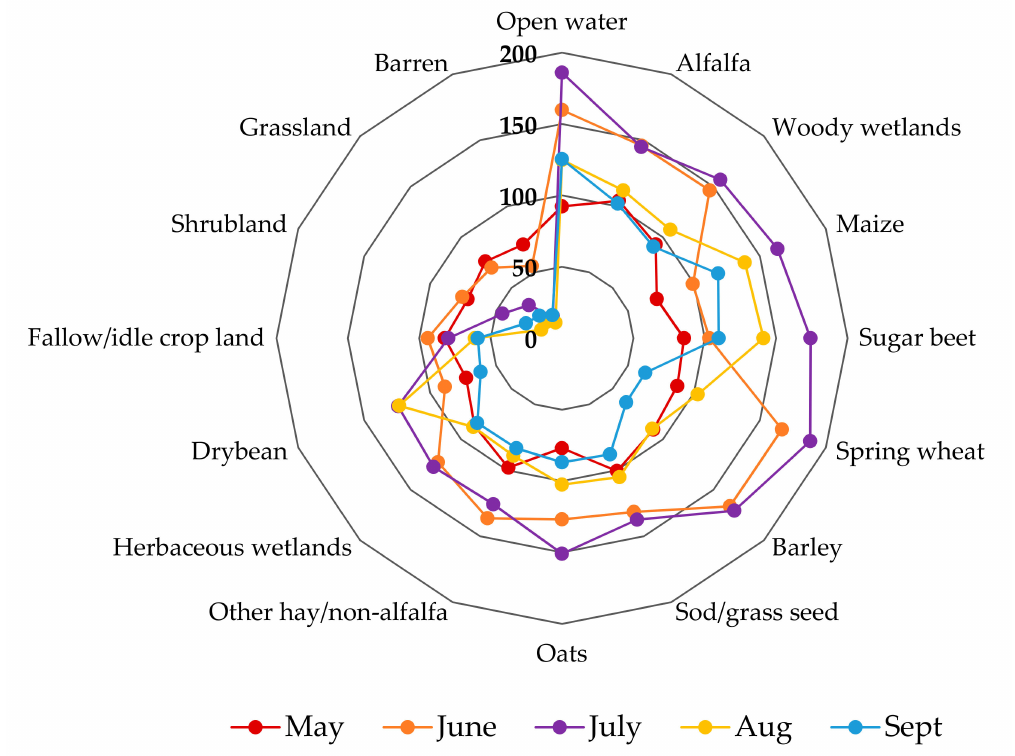
Figure 11. METRIC estimated mean monthly crop evapotranspiration (ETc, mm) across the study area during the 2018 growing season (May to September) for di ff erent land cover